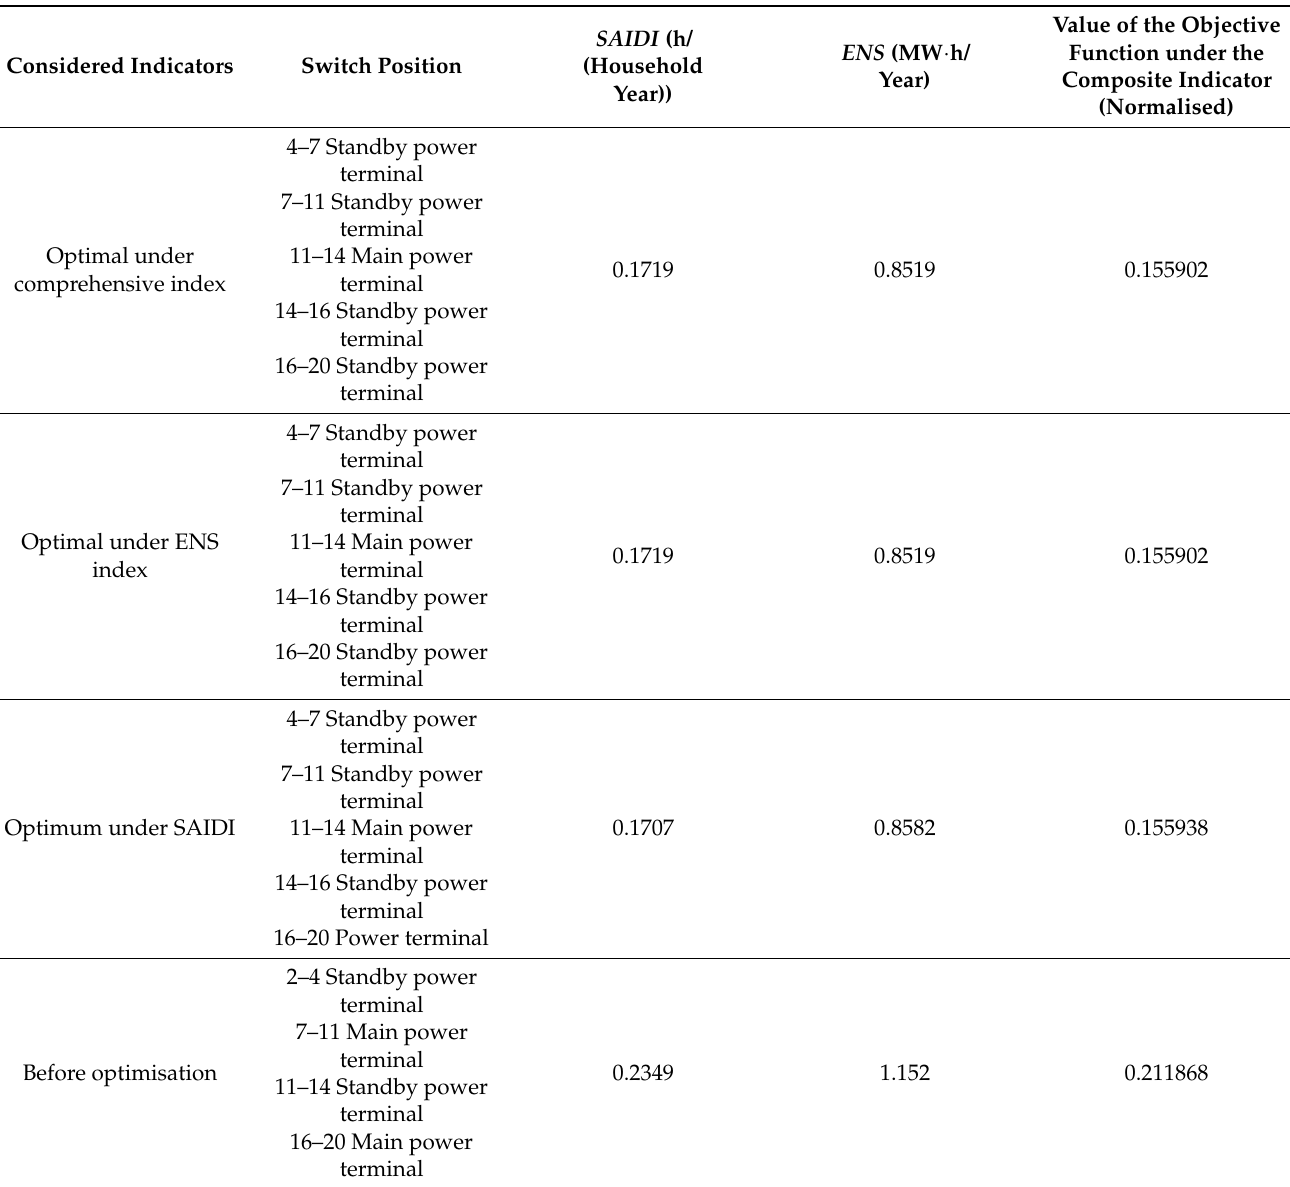
Table 5. Example 2: comparison of the switch-position optimisation